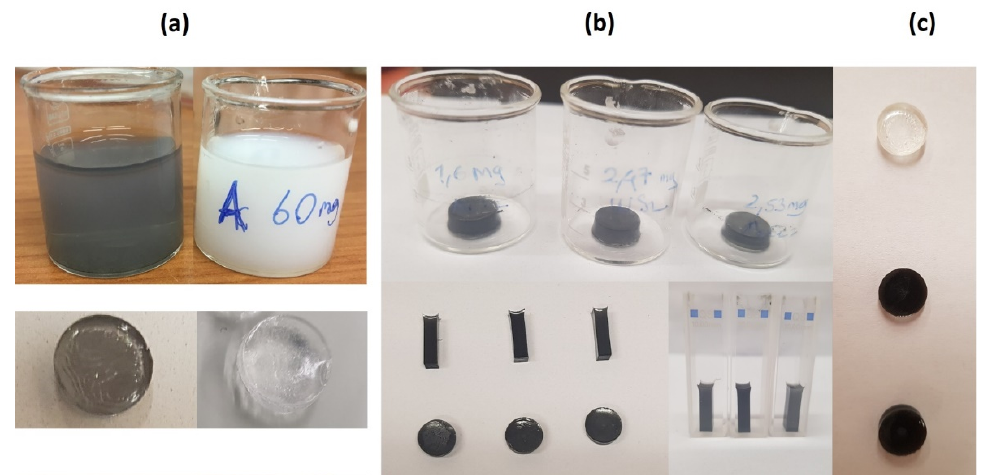
Figure 1. ( a ) Above: MoSe 2 -doped PAAm and PAAm just after the gelation. Below: The same gels after drying in air. ( b ) Above: Disc-shaped samples after drying in air. From left to right, MoS 2 , WS 2 , MoSe 2 -doped PAAm. Below: Dry gels in quartz cuvette, and disk-shaped by drying inside the beaker. ( c ) Disk-shaped gels. PAAm at the top, PAAm + 7.5 mg WS 2 in the middle, PAAm + 10 mg WS 2 at the bottom.